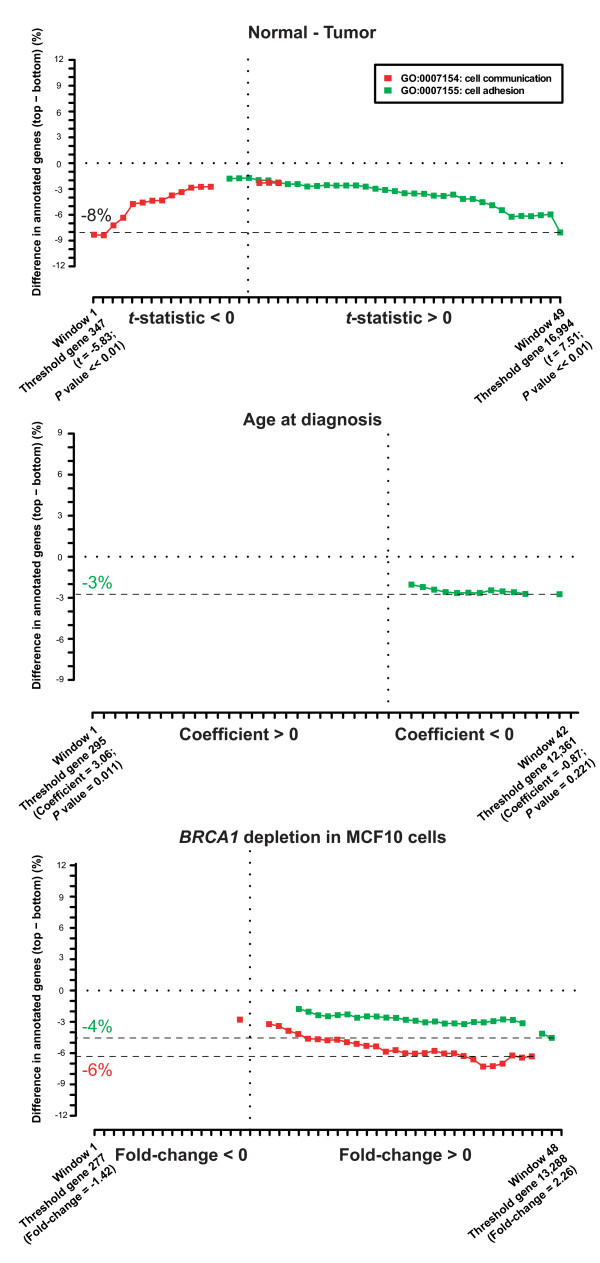
Asymmetries for Cell Communication and Cell Adhesion. Of the biological evidence of breast cancer examined in this study, three cases showed asymmetries in biological processes that are similar to those observed in the WGAS ranks. Three cases showed similar asymmetries for Cell Adhesion: 1/ top panel, differential expression between normal breast tissues and tumors measured using the t-statistic, as a result of which genes involved in Cell Adhesion are over-represented at the bottom, which indicates that they are generally under-expressed in tumors, while Cell Communication is under-represented at the top (note that both patterns follow the same direction); 2/ middle panel, association between age at diagnosis and gene expression levels measured using the coefficient from the linear model, so coefficients < 0 indicate association with early age at diagnosis, which is consistent with the expected contribution of genetic effects to breast cancer risk [57]; 3/ bottom panel, fold change in gene expression changes between BRCA1-depleted and control-treated MCF10A cells, which indicates possible molecular and/or functional dependencies on processes linked to breast cancer risk [57]. Differences in annotation percentages between top and bottom range from -8% to -4% for the most significant partition at the bottom end. On the basis of these results, all three ranks were inverted and combined for comparison with the WGAS results.